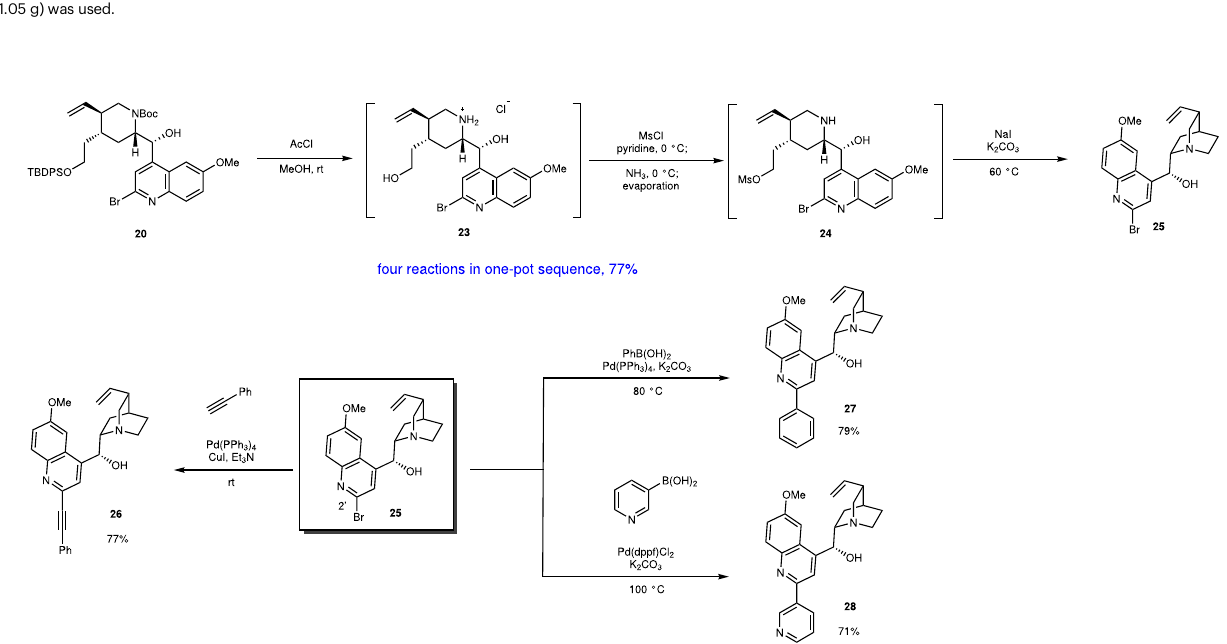
Nature Communications| (2022)